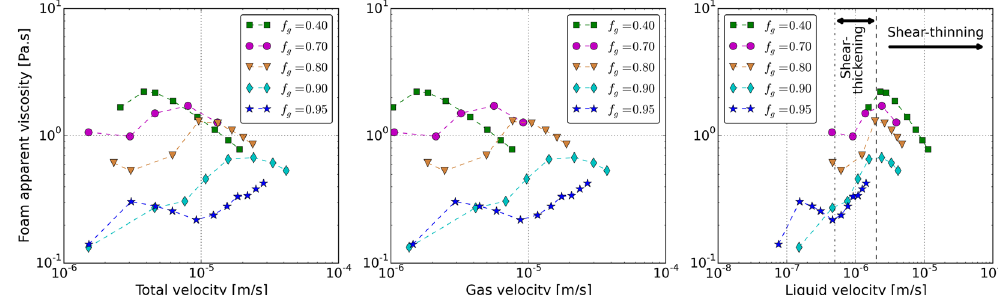
Figure 5. The calculated apparent viscosity as a function of ( a ) total velocity, ( b ) gas velocity and ( c ) liquid velocity. The vertical black dashed line in Fig. 5c indicates the minimum liquid velocity above which the generated foams show a shear-thinning behavior. Moreover, the vertical black dot-dashed line and the vertical black dashed line in Fig. 5c indicate the liquid velocity range in which the generated foams show a shear- thickening behavior.